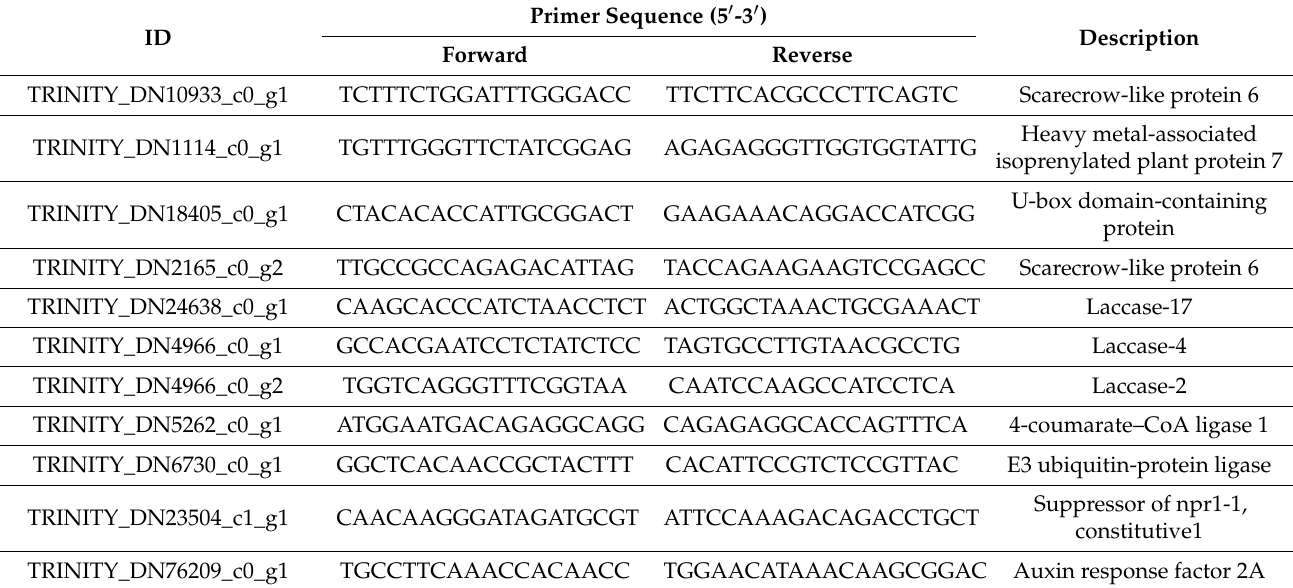
Table 1. The mRNA primers used in this study.